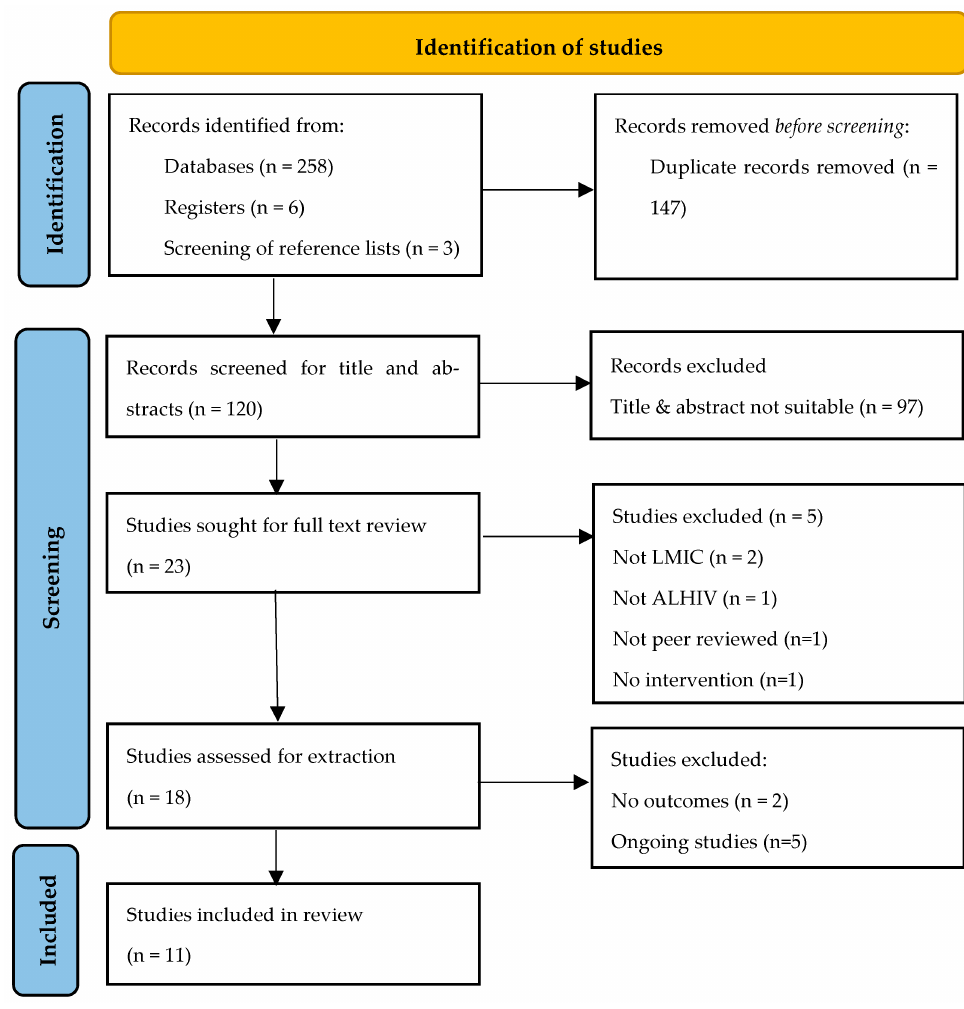
Figure 1. PRISMA diagram.